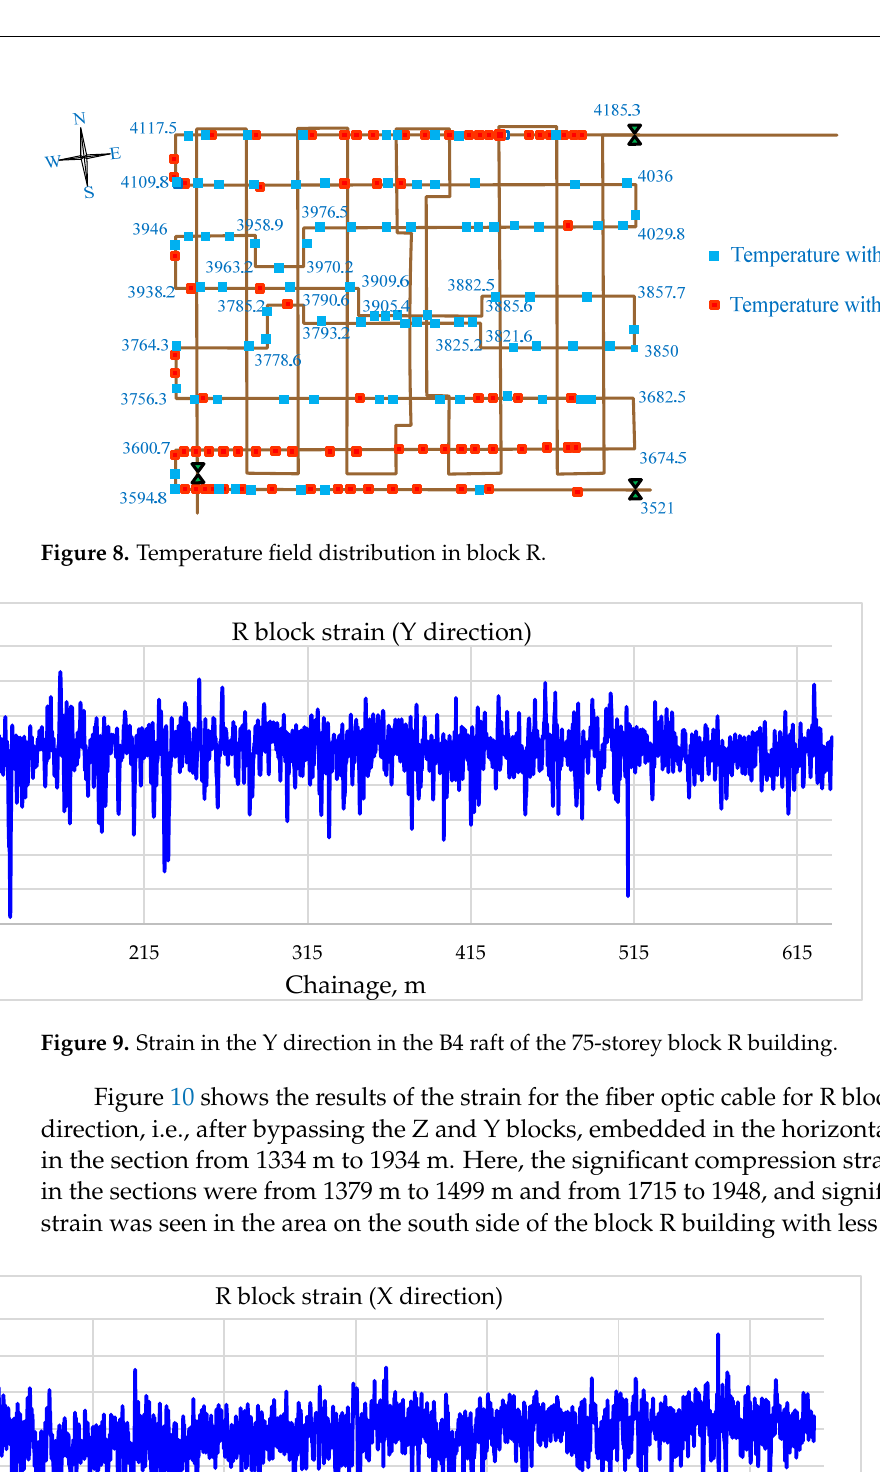
Figure 10. Strain in the X direction in the B4 raft of block R.